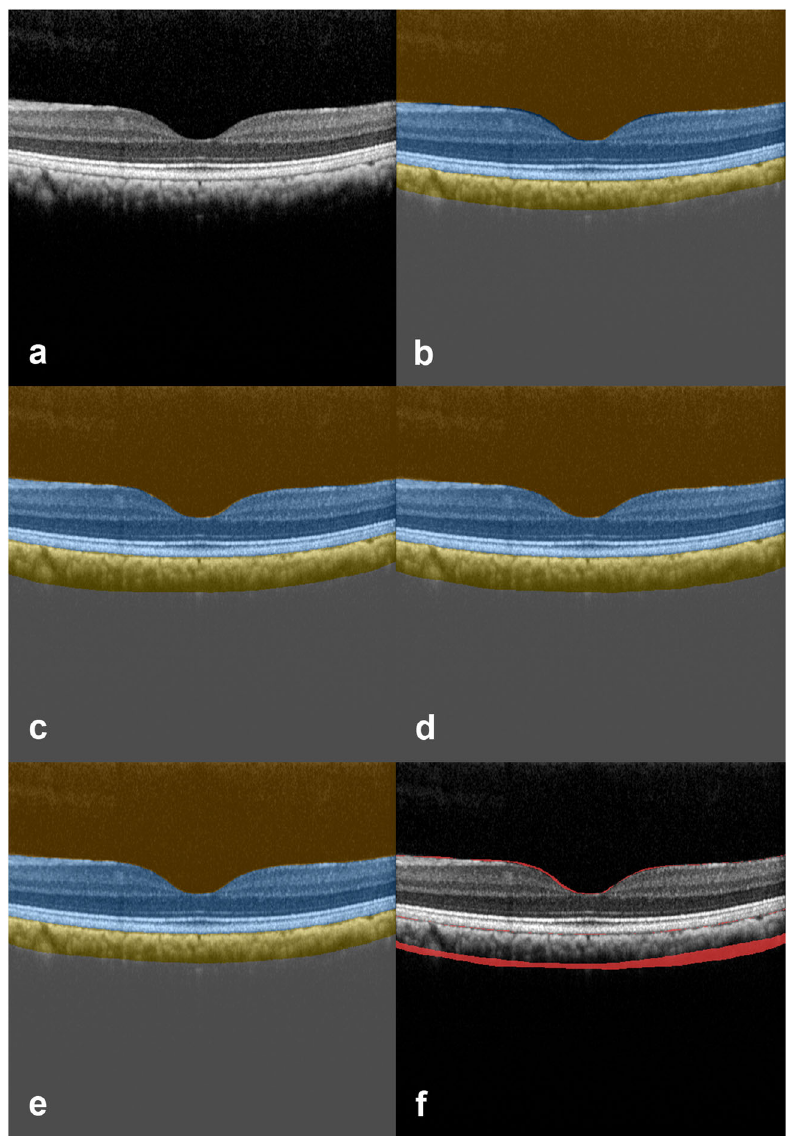
Fig. 2 Optical coherence tomography image segmentation. Visualization of an exemplary test set result from a cynomolgus monkey ’ s left macula. OCT B-scan image a , with corresponding image segmentation results derived from three human graders: b g1, c g2, d g3, and e the CNN. There was an excellent inter-grader and grader-CNN agreement for the segmentation (vitreous, orange; retina, blue; choroid, yellow; sclera, gray). The highest variability was found in the delineation of the choroidal sclera interface separating choroid and sclera. f highlights pixels in red color that were labeled differently by g1 and g3. The number of pixels in red color divided by the total number of pixels in the image is the Hamming distance between g1 and